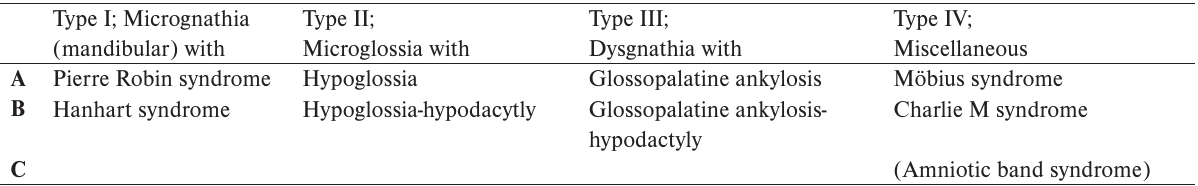
Table 2. Oromandibular Limb Hypogenesis Snydromes (OLHS): Chicarilli classification 14 .